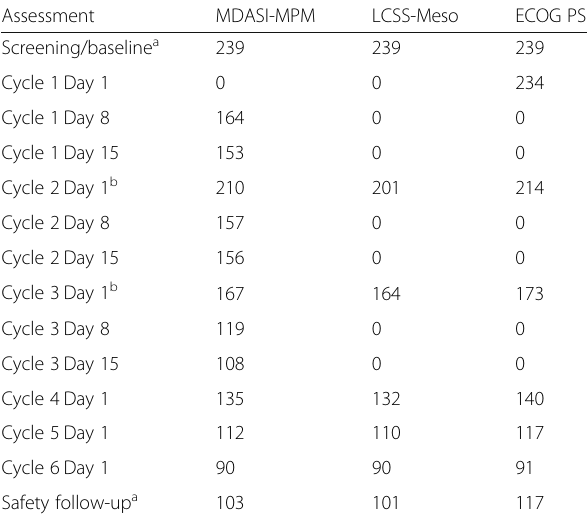
Table 1 Assessment schedule and the number of respondents at each